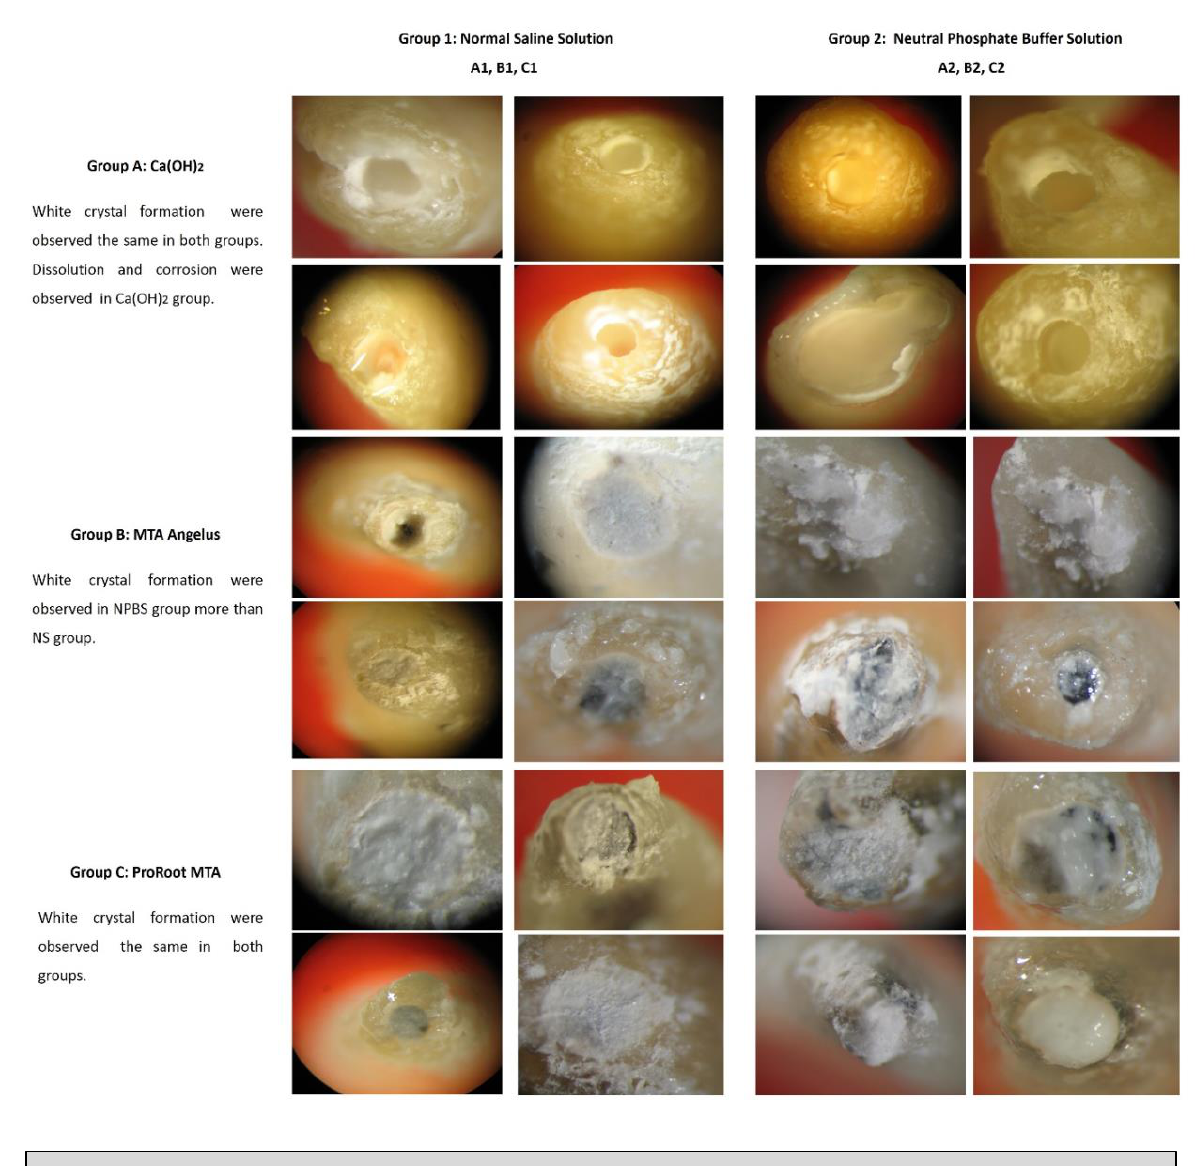
Figure 1. Stereo-microscope